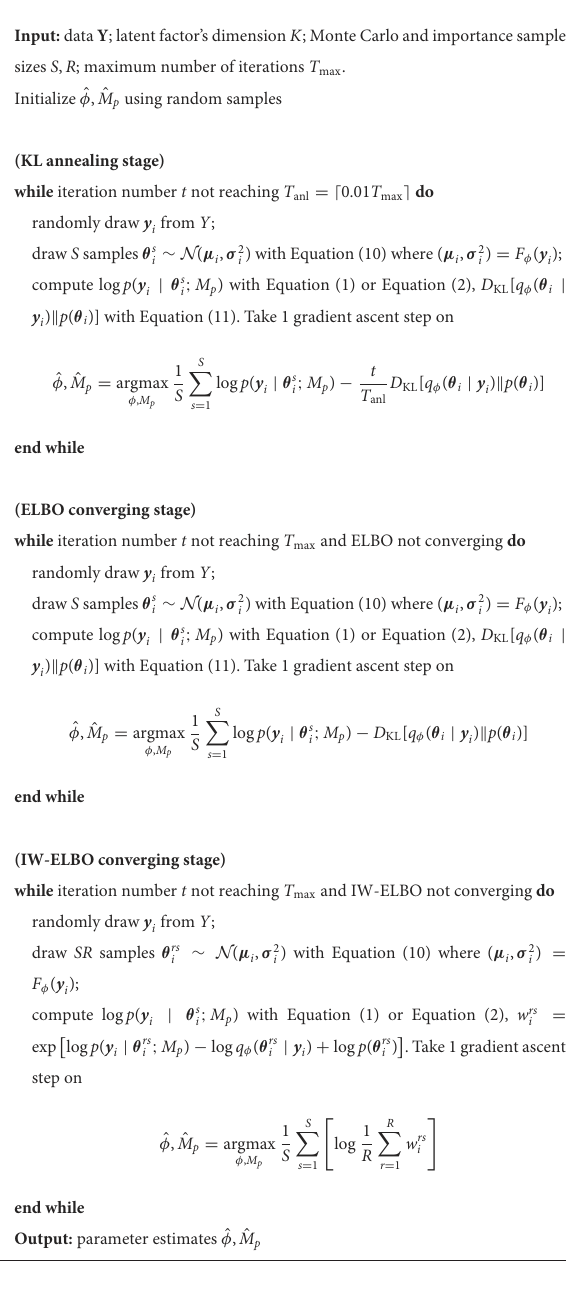
Algorithm 1 Stochastic gradient ascent of